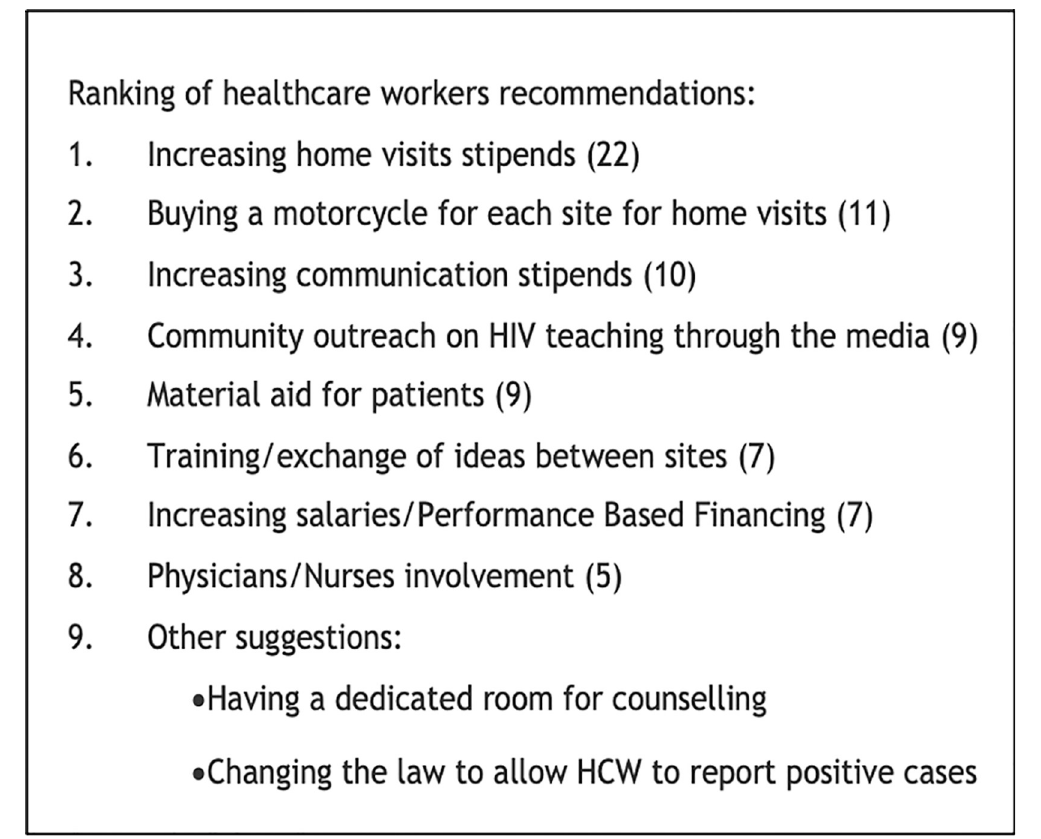
Fig 4. Ranking of community counselors’ recommendations regarding index